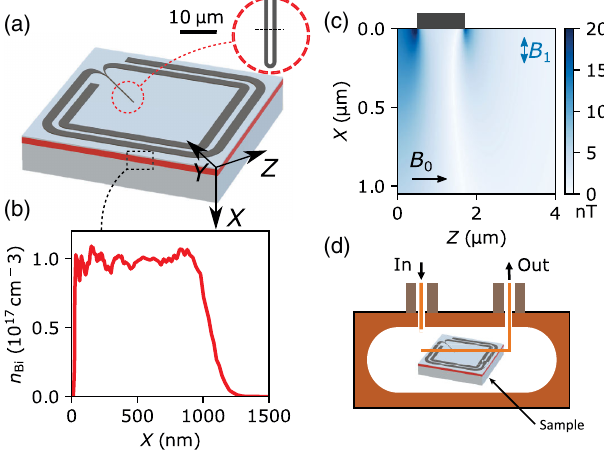
FIG. 3. Device schematic. (a) Illustration of the silicon wafer with near-surface implanted Bi layer and Nb resonator patterned on the surface. (b) Simulated Bi implantation profile as a function of depth below the substrate surface. (c) Finite element simu- lations of the magnetic field generated in the vicinity of the resonator inductor. (d) Illustration of the copper sample box with asymmetric